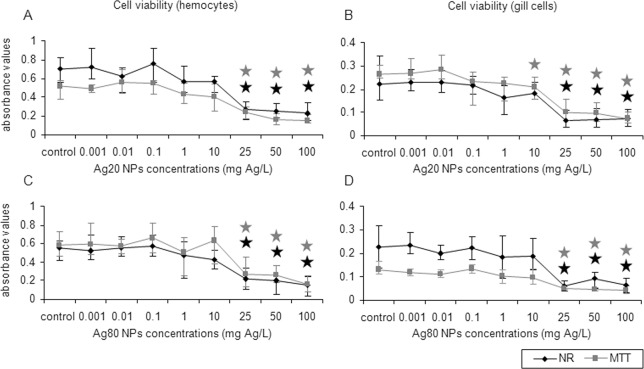
Effects of commercial Ag NPs on mussel cells viability.Cell viability (NR and MTT assays) in mussel hemocytes and gill cells exposed to Ag20 (A and B) and Ag80 (C and D) NPs for 24 h. Data are given as absorbance values (means ± confidence intervals). Stars indicate significant differences (p<0.05) in treated cells with respect to controls according to the bootstrap analysis followed by Bonferroni’s correction. Black stars correspond to the NR assay and grey stars to the MTT assay. n = 6 replicates per treatment.